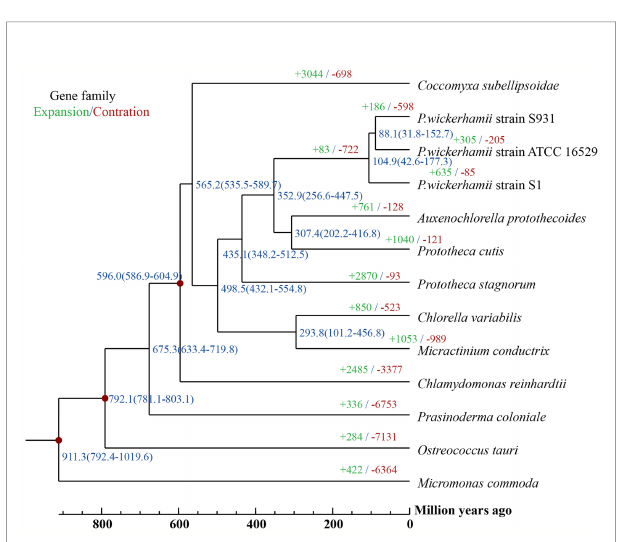
FIGURE 3 | A Phylogenetic tree and gene family expansion and contraction among 13 species. Node labels represent node ages. Expansion/contraction of gene families is shown in green and red.